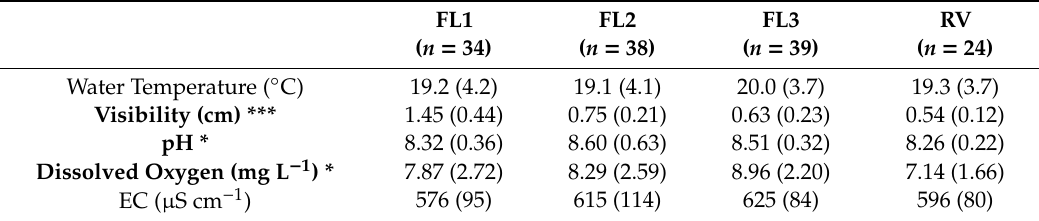
Table 2. Water parameters of the investigated floodplain lakes and the Vistula River. Data present the mean (s.d.) for every month samples in 2006–2013. Bold shows significant di ff erences (nonparametric